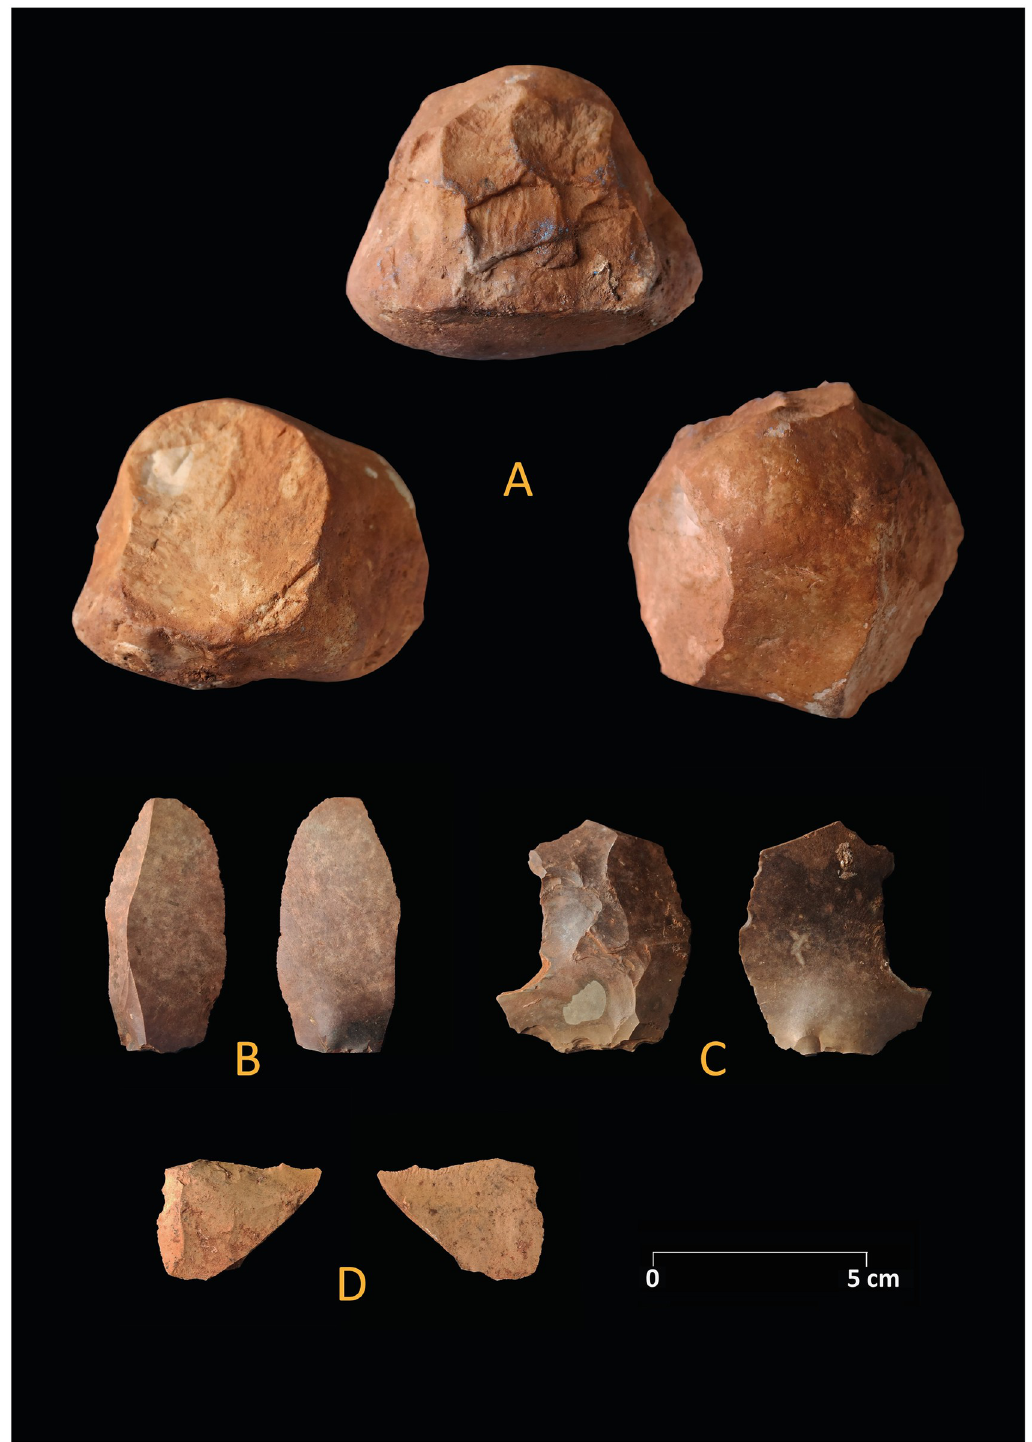
Fig 14. Lithics from the Middle Paleolithic layers of zone 3. A: Quartzite core or heavy duty tool, B: Blade, C: Levallois flake, D: Sidescraper.